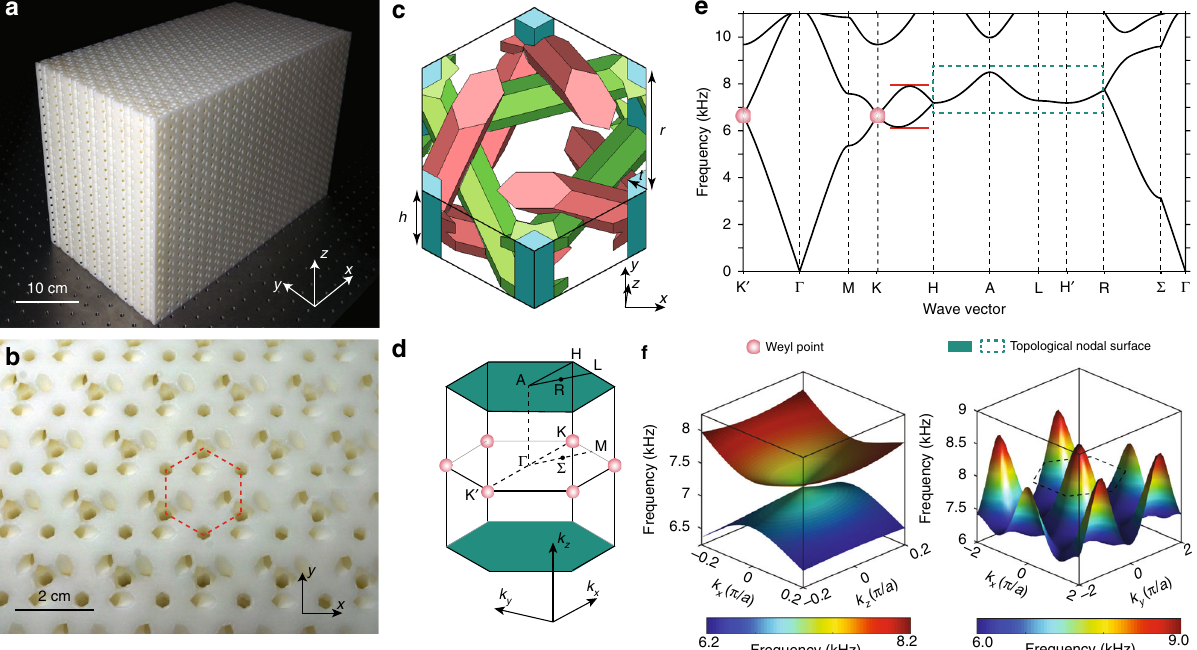
Fig. 1 A 3D arti fi cial acoustic crystal with a topological nodal surface and two Weyl points. a , b Perspective and top views of the fabricated 3D acoustic crystal sample, consisting of 23 × 13 × 20 unit cells. The dashed hexagon in ( b ) denotes a unit cell. c Schematic of a unit cell. The background is solid resin, and blue, red, and green regions represent hexagonal air tubes which have identical cross-sectional pro fi les. Here, h = 15 mm, r = 11.55 mm, and t = 2 mm. d , e 3D Brillouin zone and bandstructure of the acoustic crystal. The bands enclosed by the green dashes form the topological nodal surface, and red dots indicate the two additional Weyl points. The horizontal red lines indicate the topologically nontrivial frequency range where Fermi-arc-like surface states can exist. ( f ) 2D band structures around the Weyl points and the topological nodal surface. Each Weyl point has a topological charge of − 1, and the topological nodal surface has a topological charge of + 2, revealed via our numerical calculations (see Supplementary Note